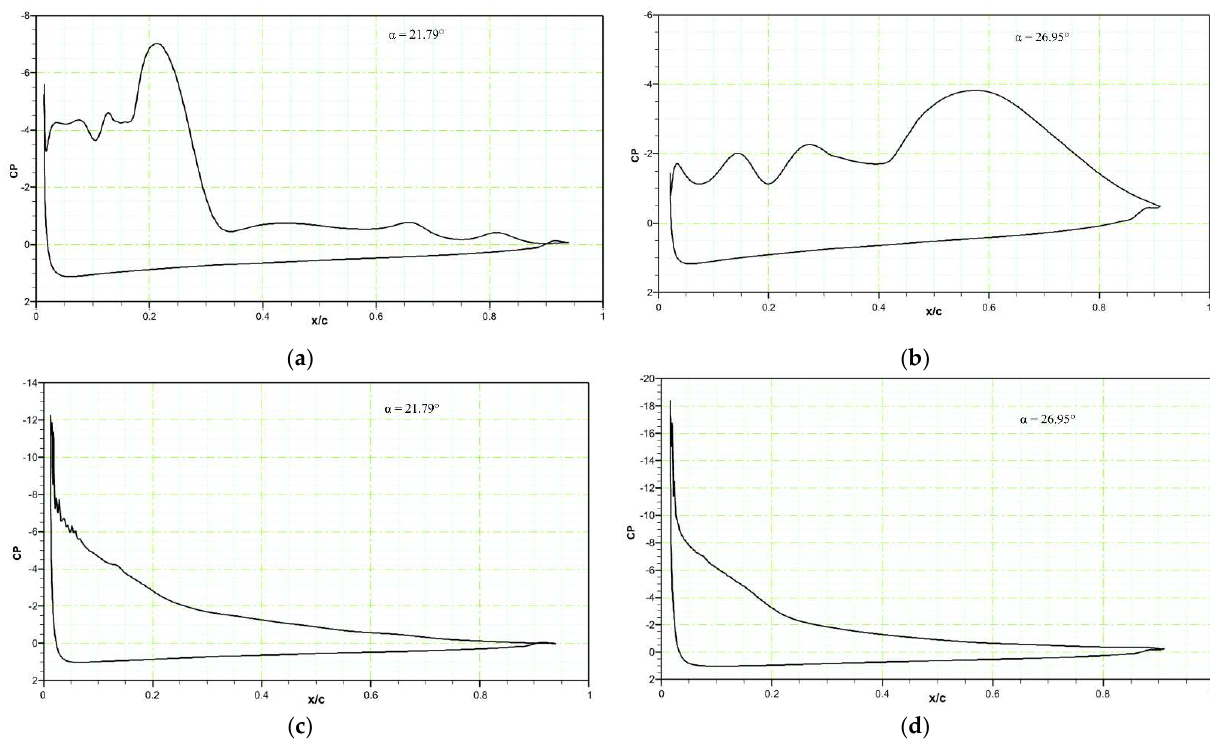
Figure 9. Pressure coefficients of the ( a ) reference airfoil at an AoA = 21.79°, ( b ) reference airfoil at an AoA = 26.95°, ( c ) the DMLE airfoil at an AoA = 21.79°, and ( d ) the DMLE airfoil at an AoA =